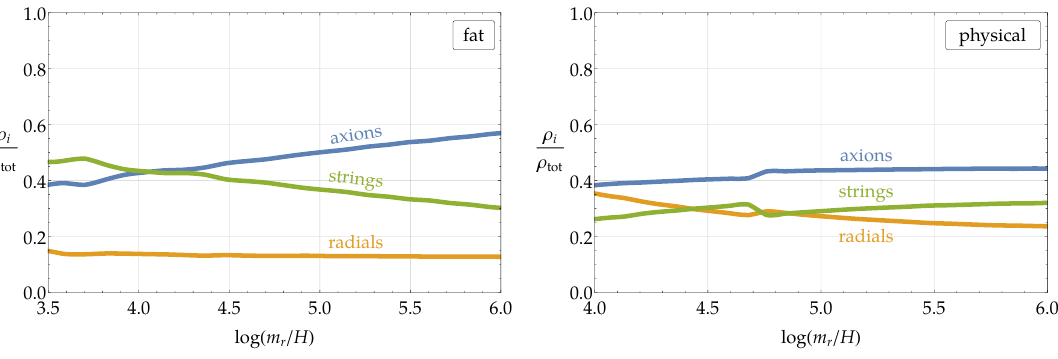
Figure 8 . The fraction of the total energy density in free axions, radial modes and strings, as a function of time using the fat string trick (left) and in the physical case (right). The string contribution (cid:26) s ( t ) is extracted from the di(cid:11)erence (cid:26) s = (cid:26) tot (cid:0) (cid:26) a (cid:0) (cid:26) r as explained in the text.